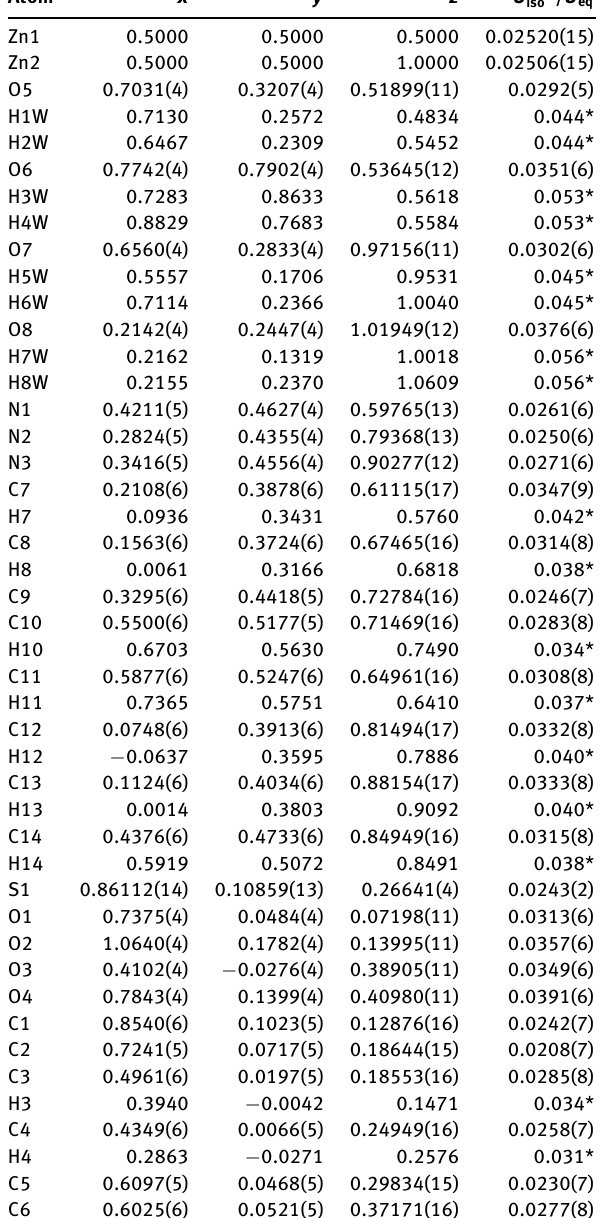
Table 2: Fractional atomic coordinates and isotropic or equivalent isotropic displacement parameters (Å 2